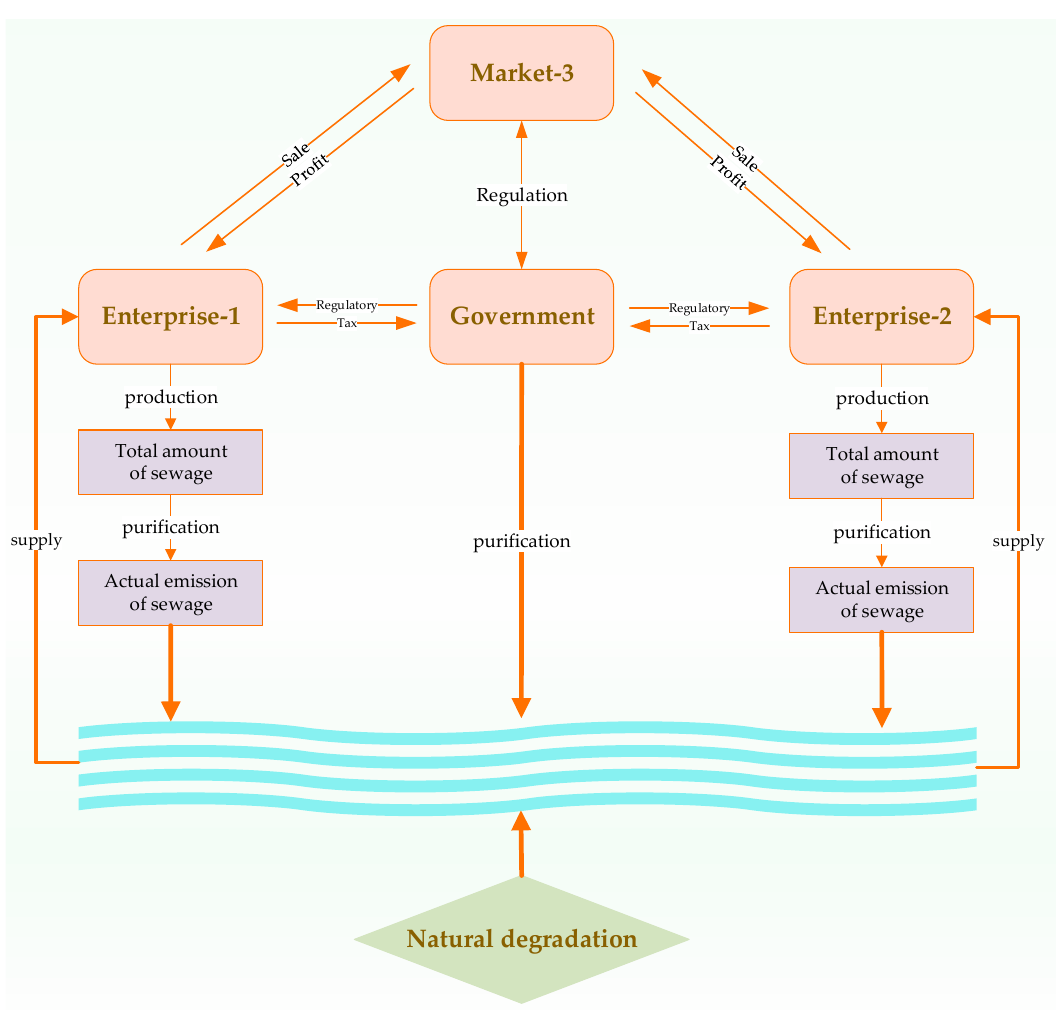
Figure 1. Schematic diagram of the whole game process.